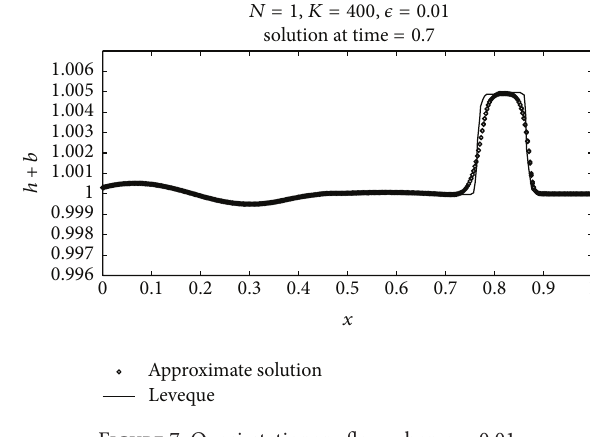
Figure 7: Quasi-stationary flow when 𝜖 = 0 . 01.